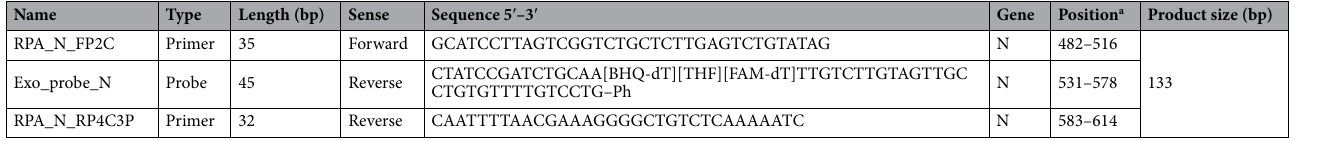
Table 4. Oligonucleotide sequences of primers and probe designed for the RABV-RPA assay. FAM: fluorescein amidit; BHQ: blackberry quencher; THF: tetrahydrofuran; Ph: phosphate; bp: base-pairs. a Corresponding nucleotide positions on genome of the rabies virus strain from Nigeria DRV-NG11(GenBank Ac. No.